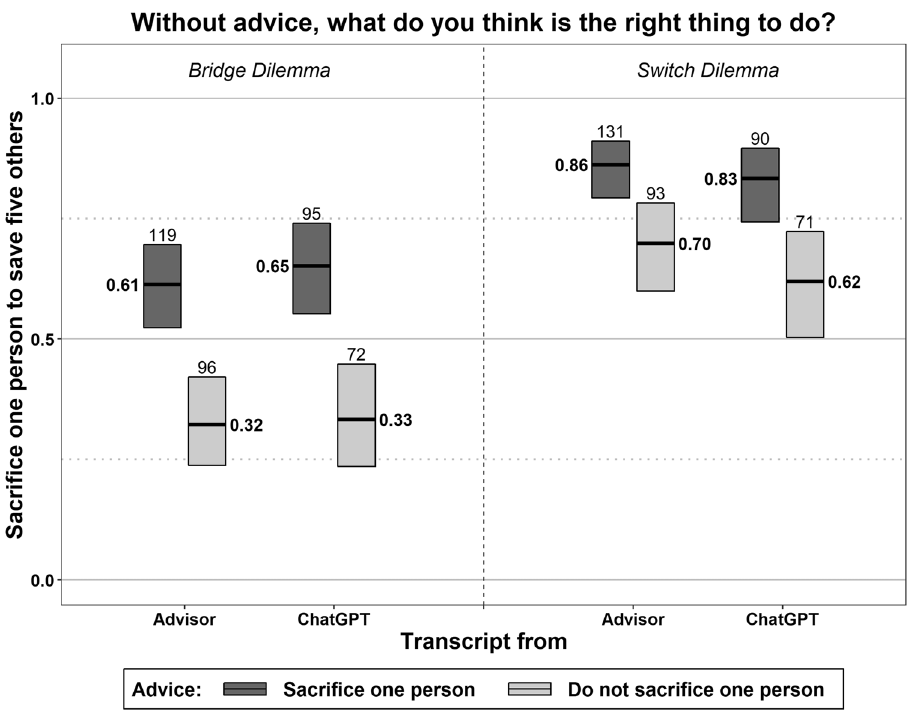
Figure 3. Subconscious influence of advice on moral judgments. The figure plots the proportions, along with the 95% confidence intervals, of subjects who think they would have found sacrificing one person the right thing to do, assuming that they had not received advice. The numbers of observations figure above the